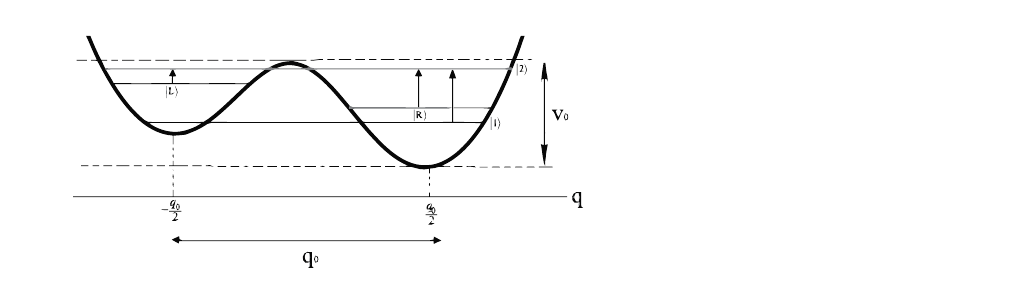
Figure 1. A scheme for the sense of smell in which odorants are absorbed by odorant receptors (ORs) in the olfactory receptor cells in the nasal cavity. In the quantum model, each odorant can be simulated as an asymmetric double-well potential for odorant recognition. The signal transduction relies on the success of an electron tunneling from a donor site of an OR to an acceptor site of the same or another OR, facilitated by a vibrational transition in the odorant according to the energy difference between the donor and acceptor sites.